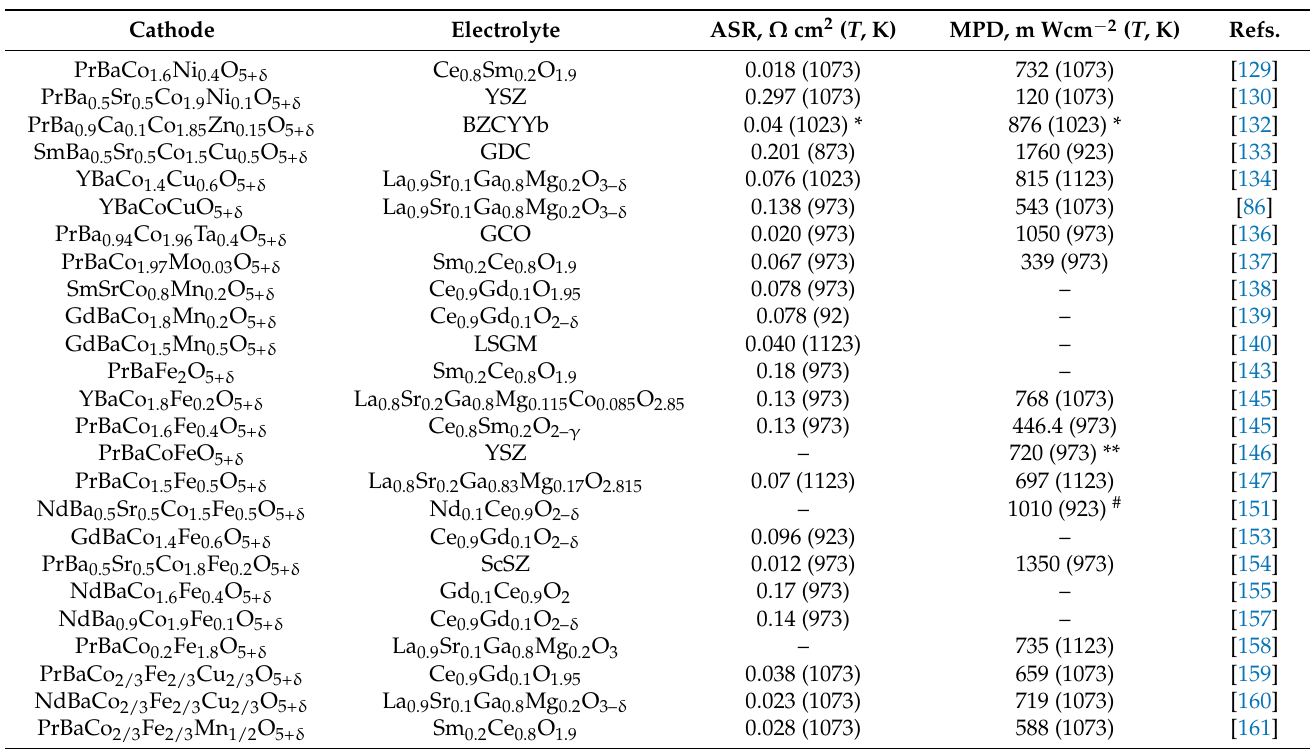
Table 5. Performance (ASR: area specific resistance, MPD: maximal power density) of SOFCs based on B-site substituted REE–barium layered double